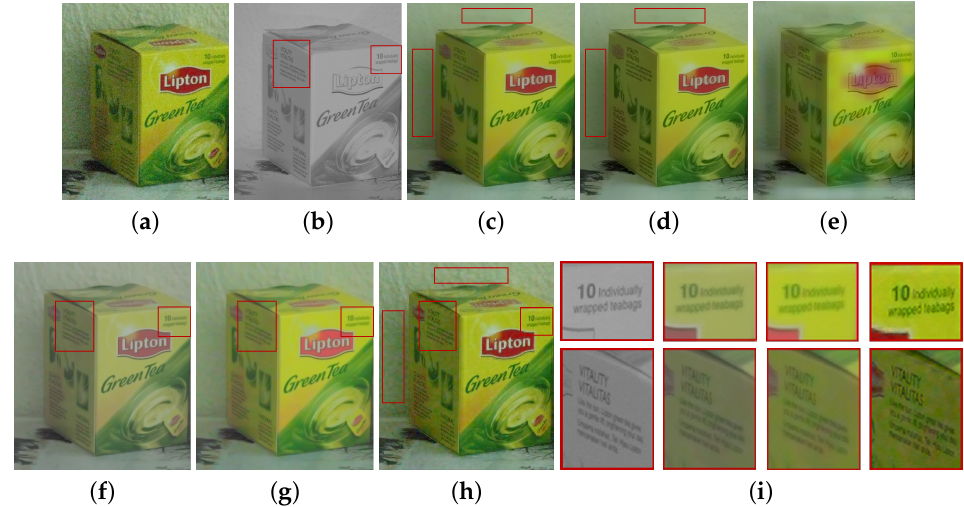
Figure 11. Experimental results for a test image. ( a ) Noisy RGB image. ( b ) NIR image. ( c ) DWLS [11]. ( d ) SM [8]. ( e ) GWS [1]. ( f ) DenseFuse [17]. ( g ) UDIF [20]. ( h ) Proposed method. ( i ) Zoomed regions of red blocks (From Left to Right: ( b , f – h ).